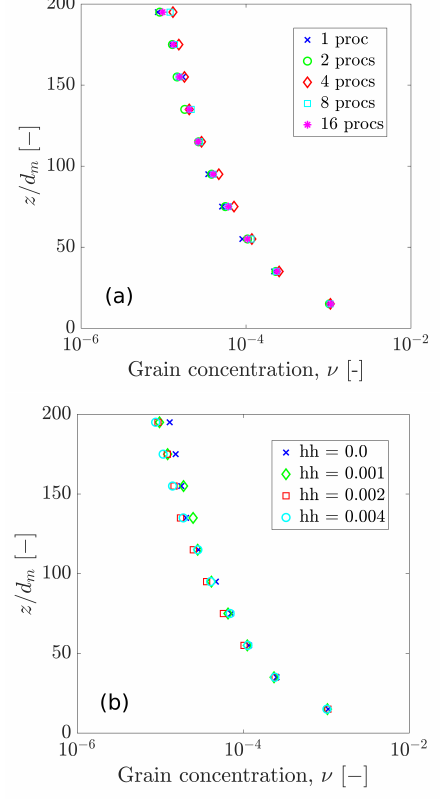
Figure 4. E ff ect of the number of processes concurring to the computation (a) and hh (b) on the vertical profile of the volume particle concentration. Computations are performed with hh = 0 in (a) and with one processor in (b).